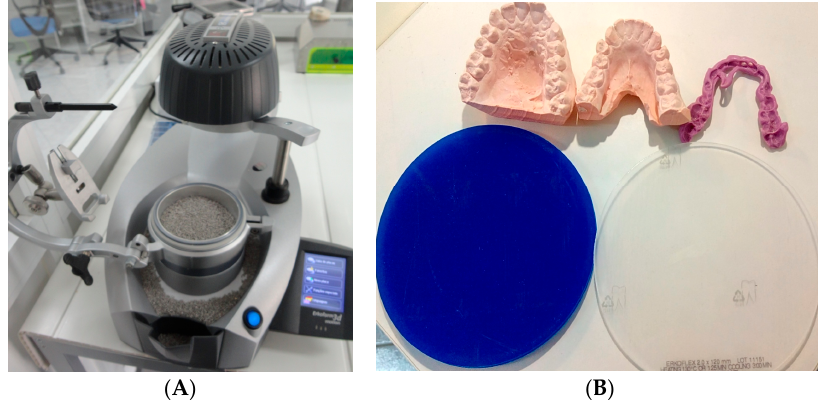
Figure 1. ( A ) Erkodent 3Dmotion, with the functions screen and respective program, at each stage of the Occlusal Stability Sports Performance Device (OSSPD) confection process, with parameters of temperature, thickness, and cooling time. ( B ) Dental casts, registration bite and ethylene vinyl acetate (EVA) sheets of 2 mm and 4 mm ( left to right ), necessary for configuring OSSPD.